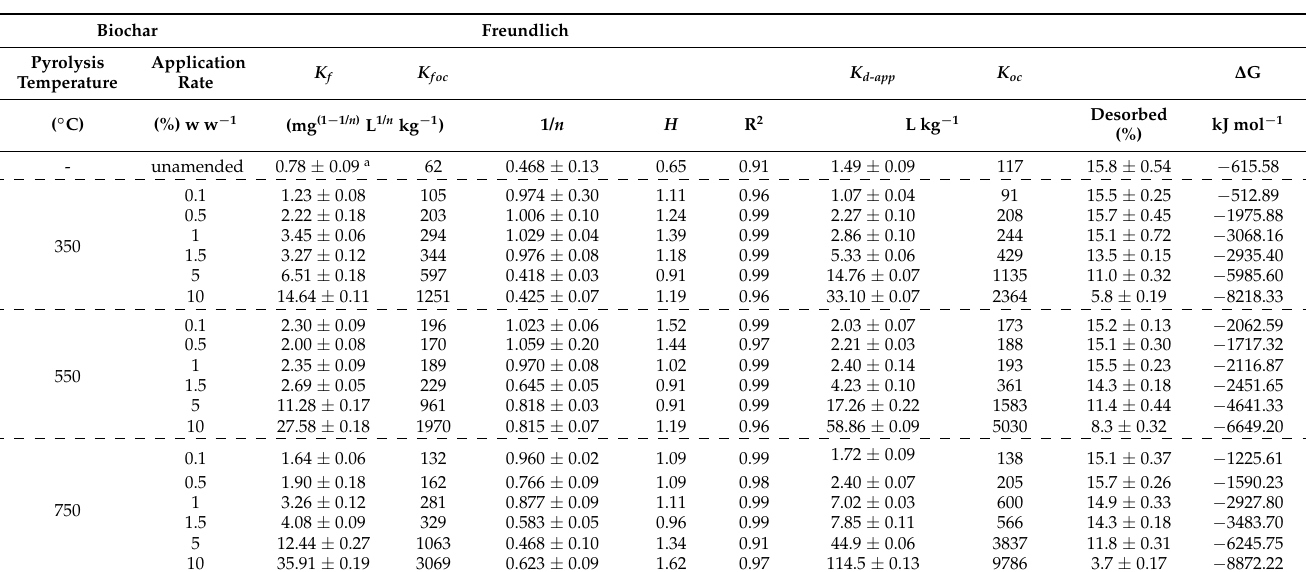
Table 4. Desorption isotherm parameters of Freundlich model. Sorption coefficient ( Kd - app ) of 2 mg L − 1 . Hysteresis coefficient (H) and Gibbs free energy ( ∆ G) for metribuzin applied to soil amended with sugarcane straw biochar and unamended